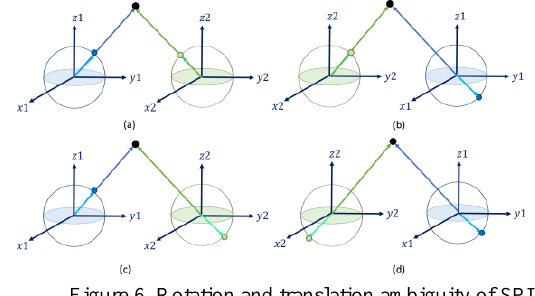
Figure 6. Rotation and translation ambiguity of SPI